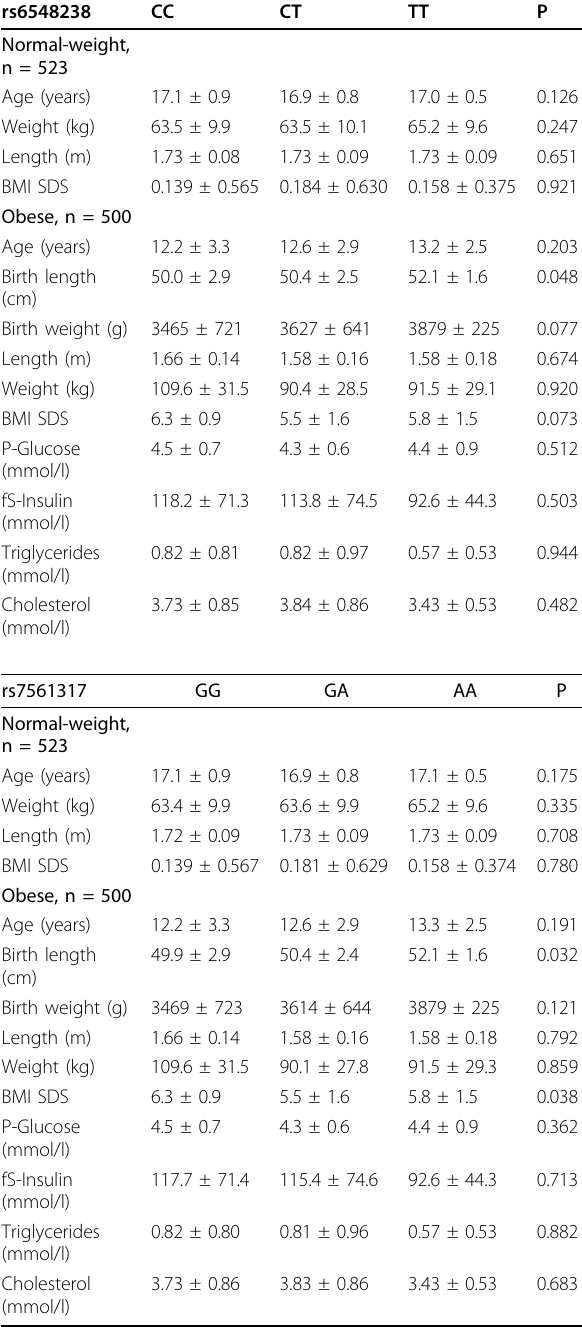
Data are means and SD divided into genotype groups. P indicates p-values adjusted for significant